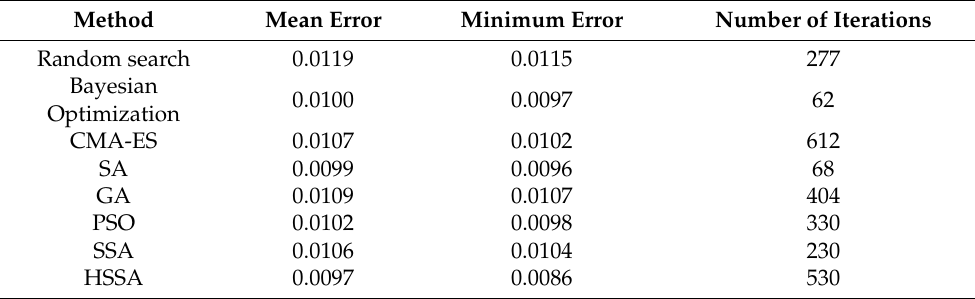
Table 9. Results analysis on